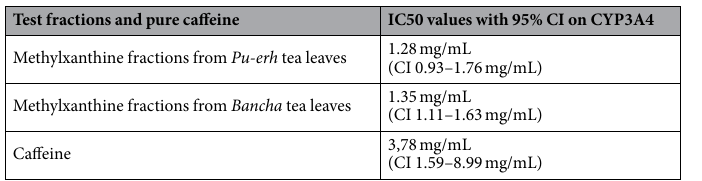
Table 2. Determined IC 50 values of methylxanthine fractions isolated from Pu-erh and Bancha tea leaves and pure caffeine. Values are expressed as mean with 95% CI for three independent observations.